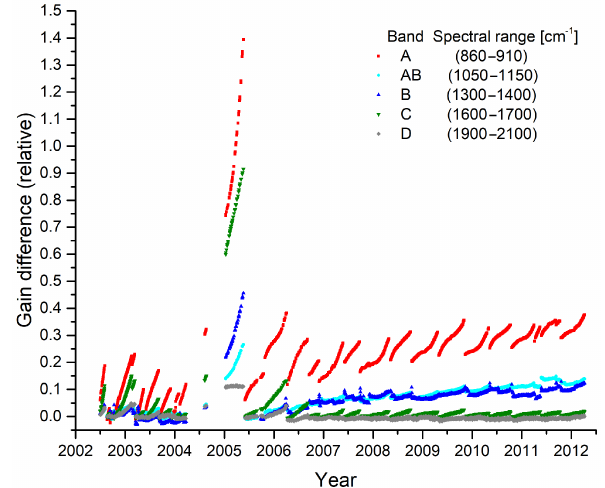
Figure 6. Relative gain difference with respect to orbit 2552 of 26 August 2002 in selected spectral regions over the mission.